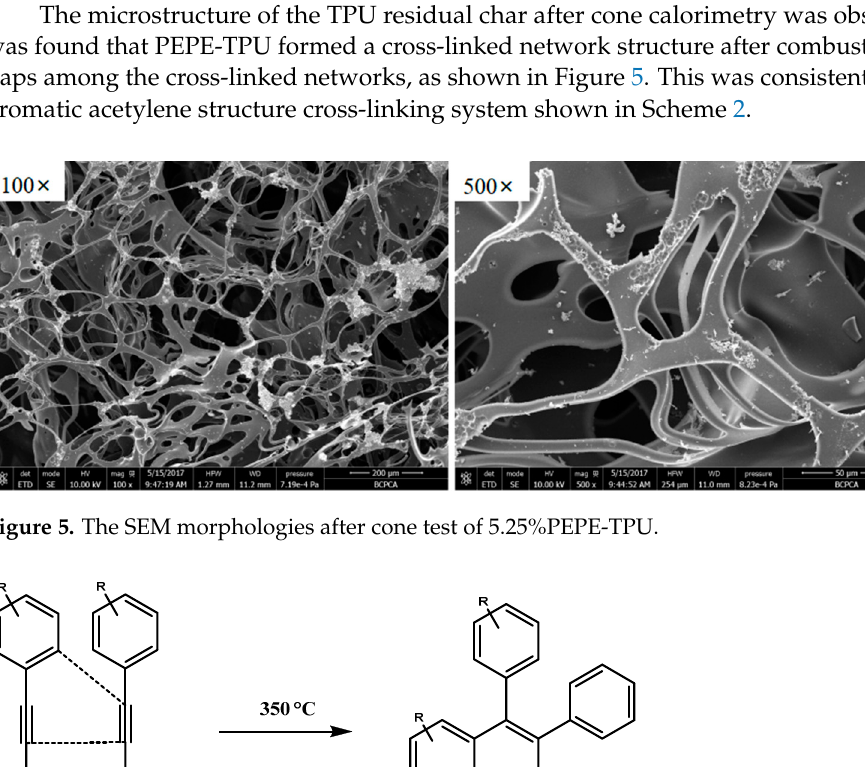
Figure 4. Digital photographs of char after cone test. Table 4. Cone calorimetry data of flame-retardant TPU with PEPE.